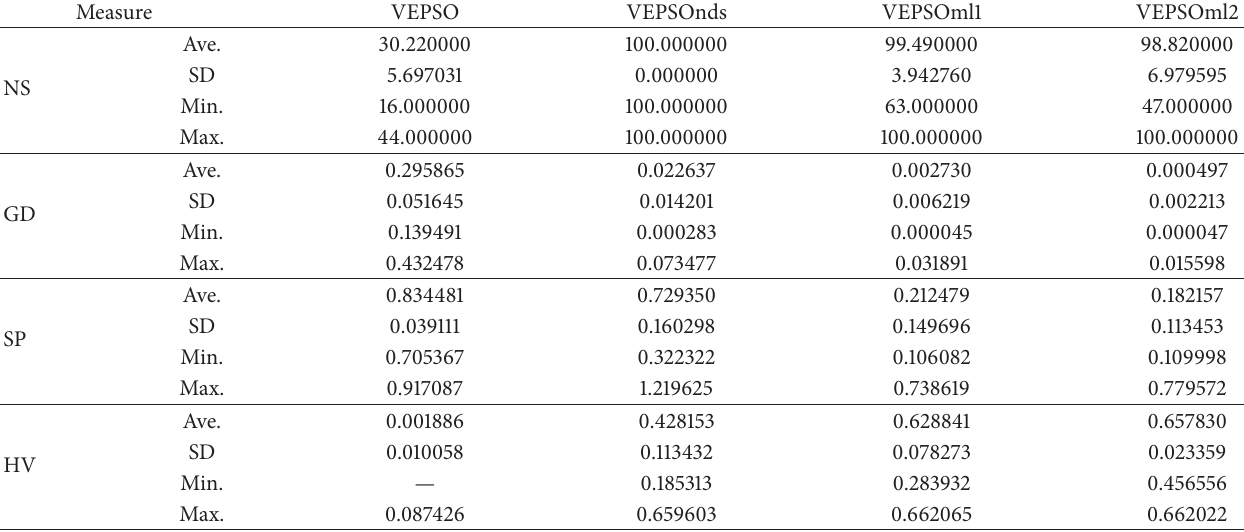
Table 2: Algorithm performance tested on ZDT1 problem.